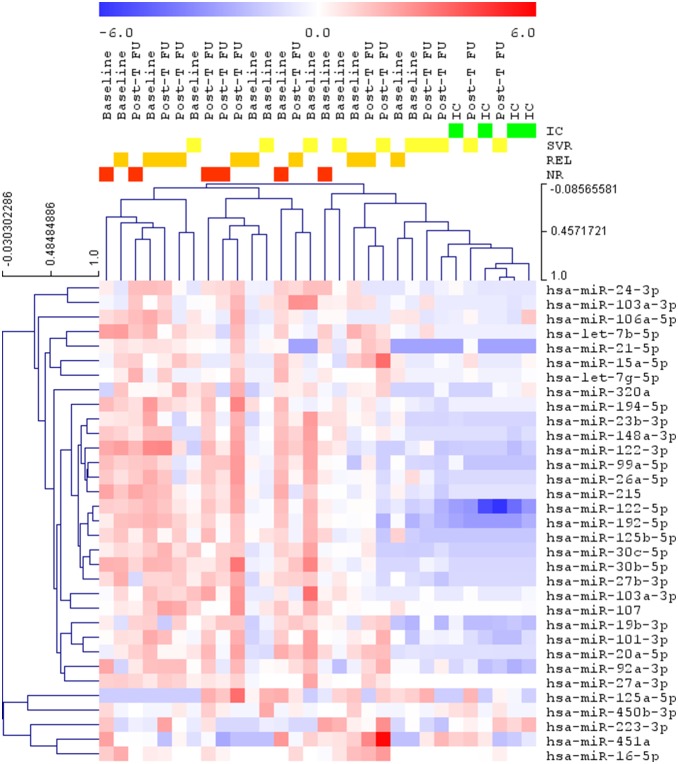
Hierarchical clustering of miRNAs from HBsAg particles and samples.The heatmap shows the result of the two-way hierarchical clustering of miRNAs from HBsAg particles and samples (zero centered). The colour scale shown at the top illustrates the relative expression level of a miRNA across all samples: red colour represents an expression level above mean, blue colour represents expression lower than the mean. The SVR post-T FU (Peg-IFN treated patients) group clusters with the IC group.